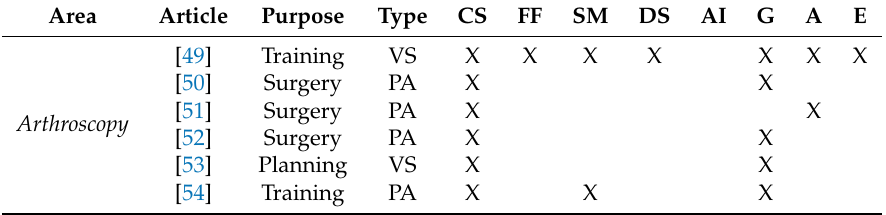
Table 1. Comparison between applications—Guidance and evaluation aspects. PA: